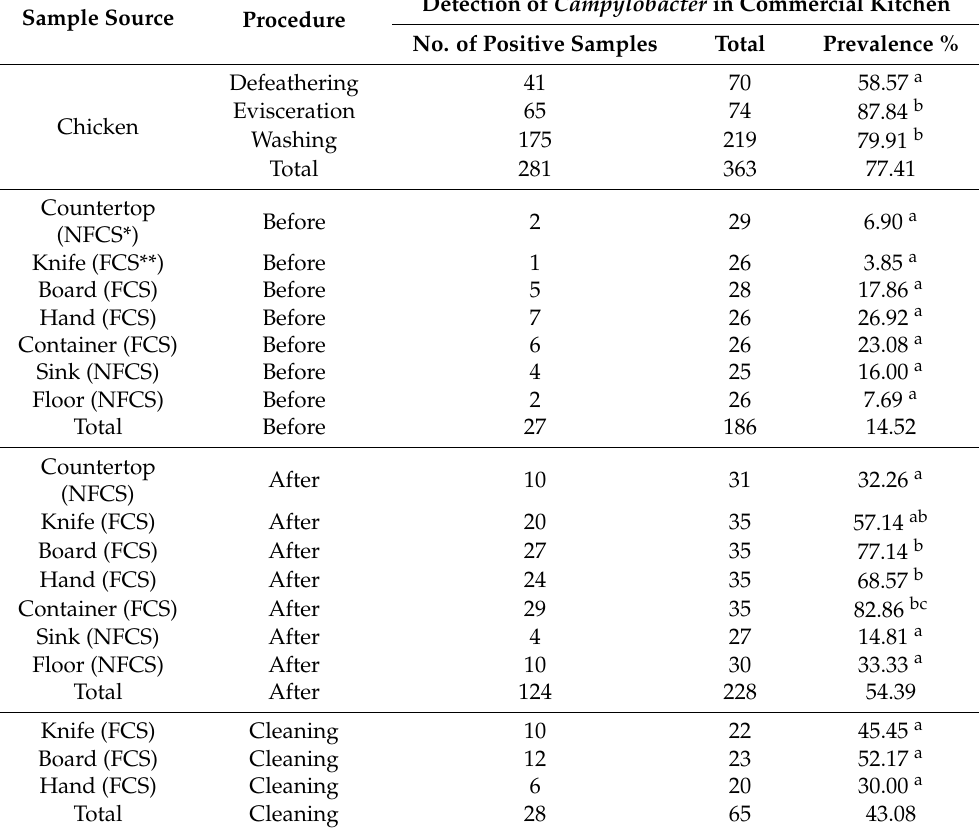
Table 2. Detection of Campylobacter spp. on chicken and sampling sites at commercial kitchens facilities in